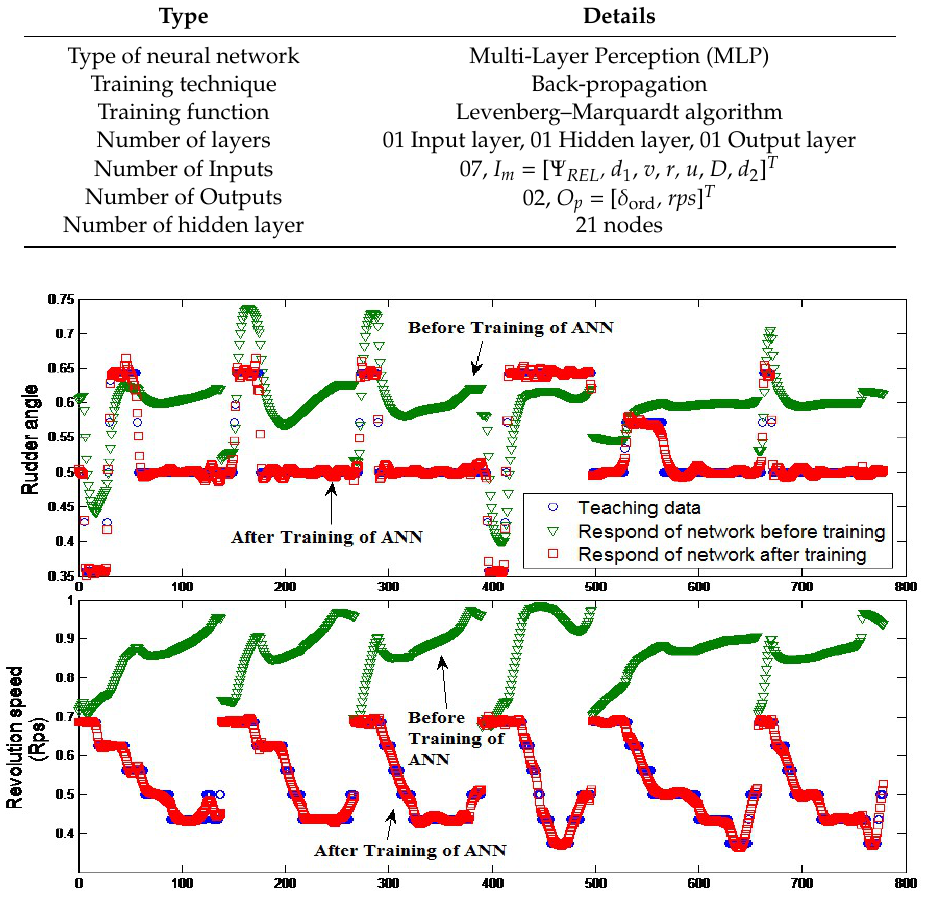
Figure 9. The result of training the ANN with teaching data in the original port.